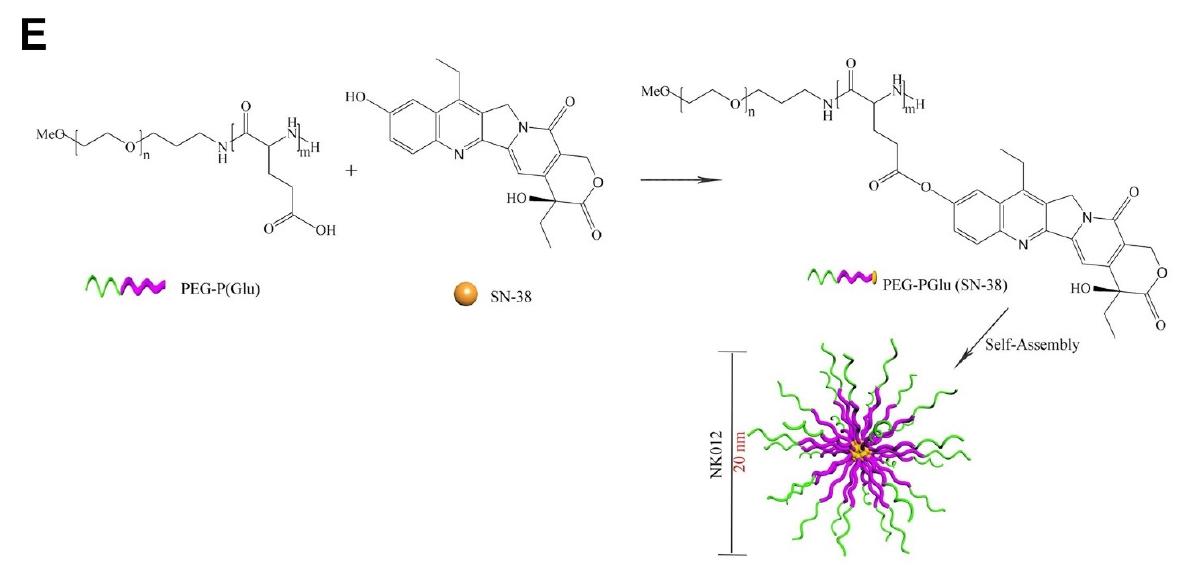
Figure 7. Chemical structures and schematic diagrams of PMs and respective drug candidates in the clinical trials, polymers used in the preparation (subscript represents molecular weights in Dal- tons) and drug molecule names are presented: ( A ) Genexol-PM block copolymer of poly(ethylene glycol) 2000 - b -poly(D,L-lactide) 1750 and paclitaxel (PTX); ( B ) NK105 block copolymer of PEG 12000 - b -poly (4-phenyl-1-butanoate-L-aspartamide) 8000 and paclitaxel (PTX); ( C) Nanoxel-PM block copolymer of poly(ethylene glycol) 2000 - b -poly(Lactide) 1765 and docetaxel; ( D) Docecal XR-17 (N-all-trans retinoyl cysteine methyl ester sodium salt and N-13-cis retinoyl cysteine methyl ester sodium salt) and docetaxel; ( E ) NK012 block copolymer of poly(ethylene glycol) 12000 - b -poly(l-glutamic acid) and docetaxel modified and reprinted from [104] with permission from Elsevier, © 2022 Published by Elsevier B.V. on behalf of the Chinese Chemical Society and Institute of Materia Medica, Chinese Academy of Medical Sciences. Table 3. PMs that are clinically approved and undergoing clinical trials [112].